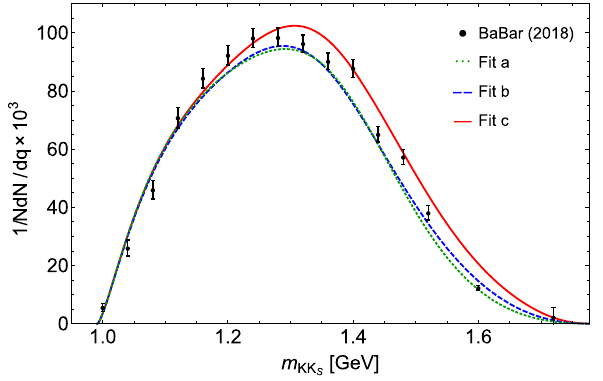
Fig. 8 BaBar data [16] for τ − → K − K S ν τ (black solid circles) as compared to our fits obtained from a simultaneous analysis of | F π and τ − → K − K S ν τ (see Table